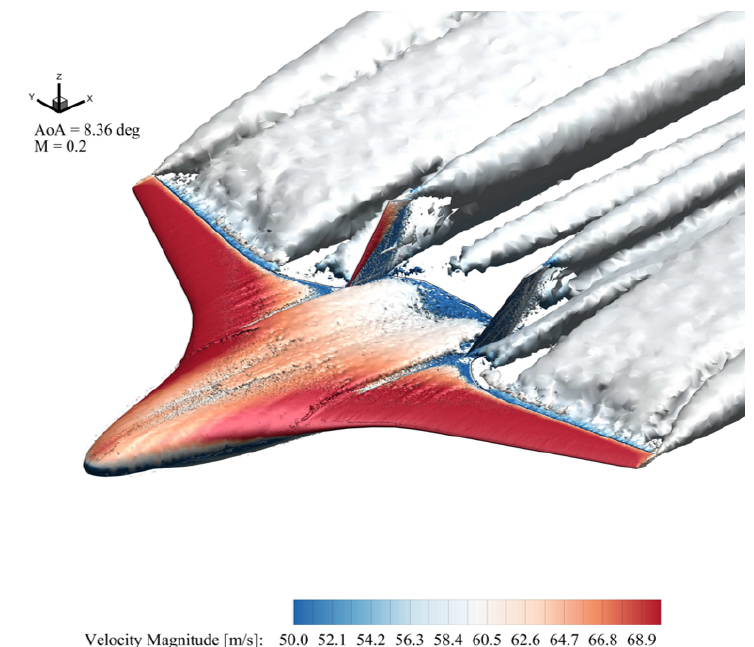
Figure 11. Three dimensional visualization of mean flow field at α = 8.36 ◦